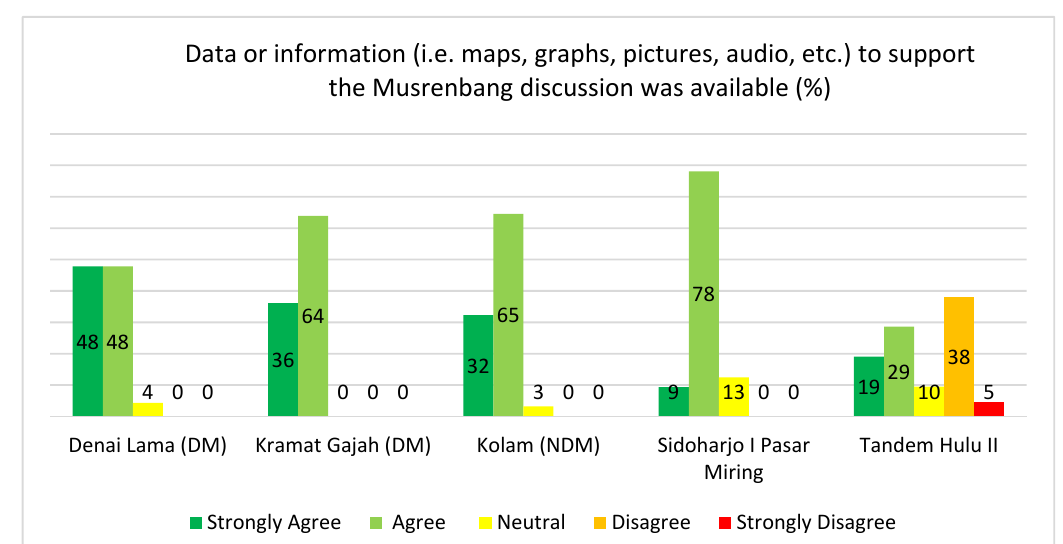
Figure 5. The availability of data to support the Musrenbang process. This finding indicates that the participants in the intervention villages were aware that the village maps shown during the meeting made the latest Musrenbang different from previous ones. Respondent A9 considered the 2020 Musrenbang to be better than those in previous years. He said that the maps enhanced the deliberative process of the Musrenbang; the discussion was more constructive and faster because participants could directly identify, see, and point to the locations being discussed on the maps. Previously, they only discussed development priorities or plans without supporting data that clearly showed the exact locations (A9, personal communication, 18 February 2020).